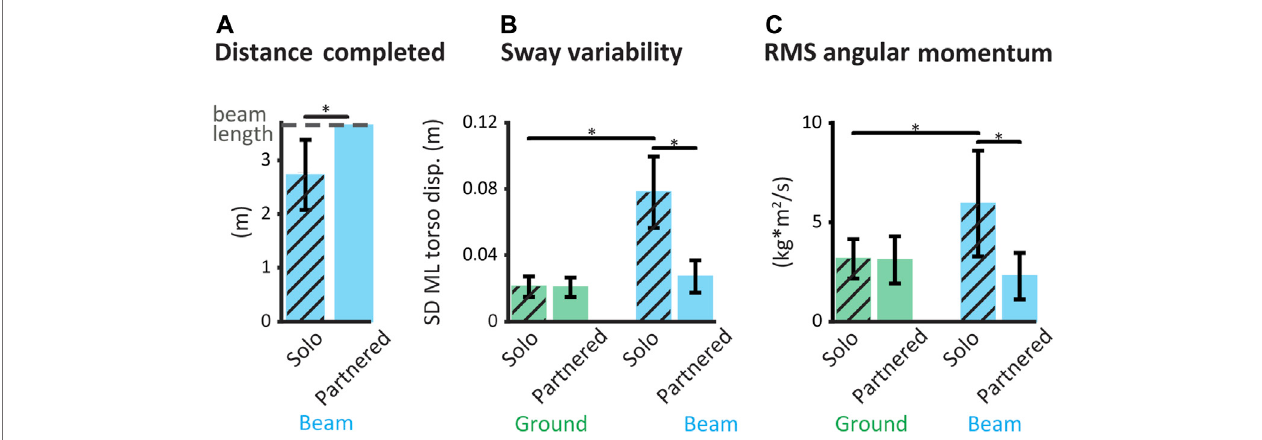
FIGURE 3 | Balance performance metrics in solo and partnered beam-walking. * t -test p < 0.05. Error bars represent ± one standard deviation. (A) Mean beam distance completed per trial. All partnerships completed the entire beam length (dashed line) on every partnered beam-walking trial. (B) Mean sway variability of beam-